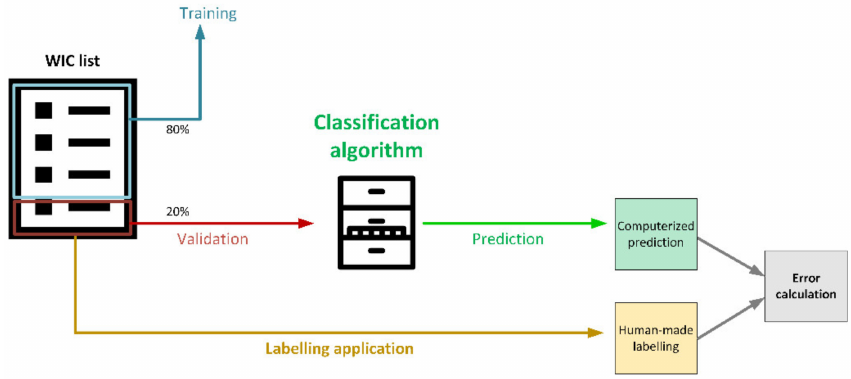
Figure 13. Validation